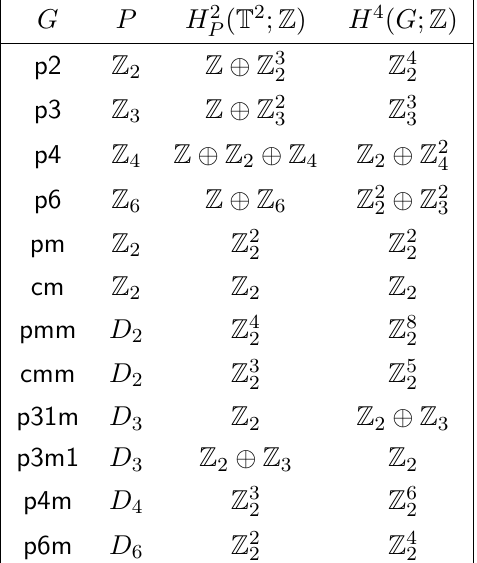
Table 1 . m = 1 , d = 2 bosonic symmorphic crystallographic phases ( H 2